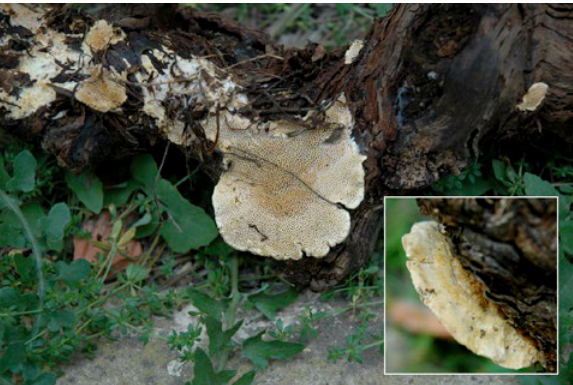
Figure 10. Hymenial and upper surfaces of fruitbodies of Trametes hirsuta on a living grapevine; note pileate appear - ance and different developmental stages. Photograph: V.